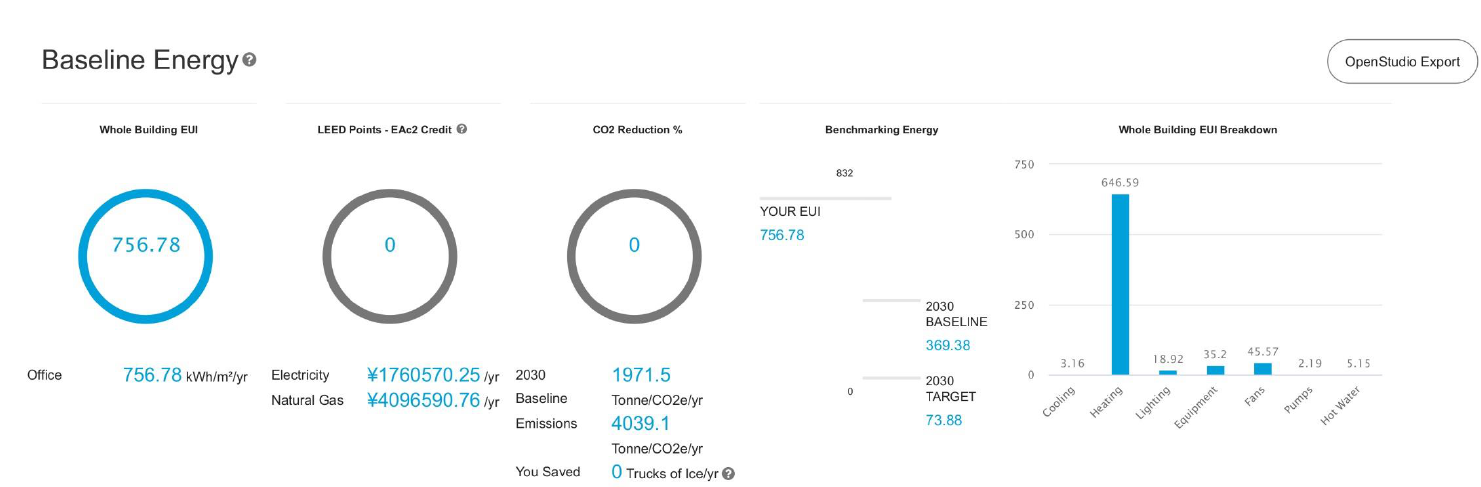
Clean Technol. 2022 , 4 , FOR PEER REVIEW Figure A39. Zone 6-H Xi’ning, Qinghai (post-COVID-19 84% scenario). Figure A39. Zone 6- H Xi’ning, Qinghai (post-COVID-19 84% scenario).